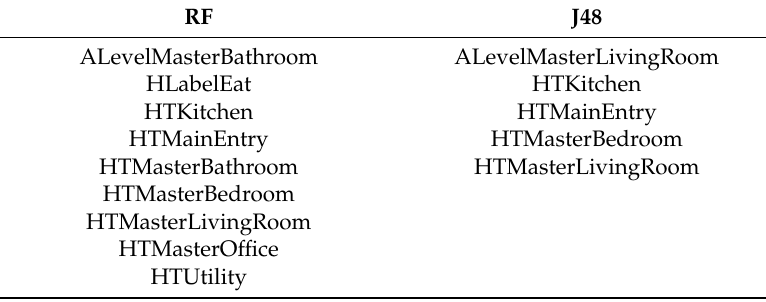
Table 9. Selected SH attributes that as a group predict indoor formaldehyde in IAQ 1 .